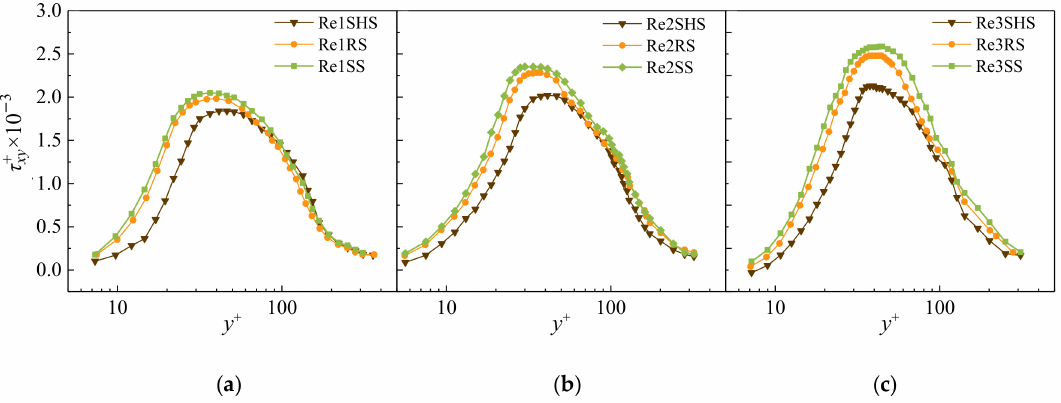
Figure 5. Variation in Reynolds shear stress τ + xy along the normal distance y + . ( a ) Reynolds shear stress of Re1. ( b ) Reynolds shear stress of Re2. ( c ) Reynolds shear stress of Re3.